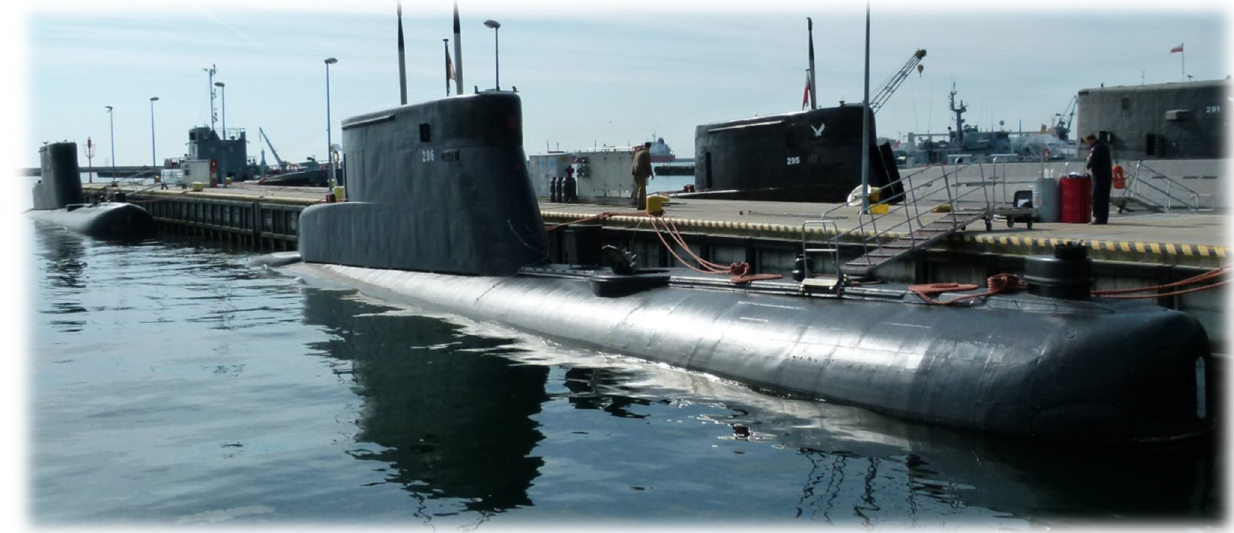
Figure 1. Submarines of project 207 (Kobben) in the home port in Gdynia